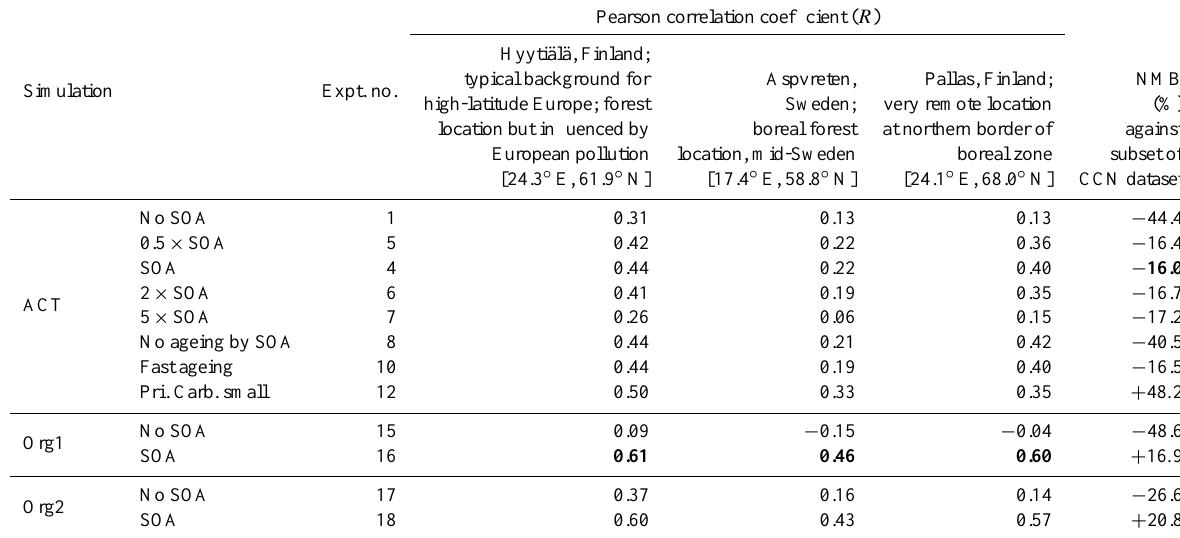
Table 3. Pearson correlation coefficient ( R ) between multi-annual monthly mean observed and simulated monthly mean N 80 concentrations. The normalised mean bias (NMB, %) in surface CCN concentration between model and observations is also given for each simulation. The simulation with the best correlation at each location, or smallest NMB, is highlighted in bold. Pearson correlation coefficient ( R ) Hyytiälä, Finland; typical background for Aspvreten, Pallas, Simulation Expt. no.